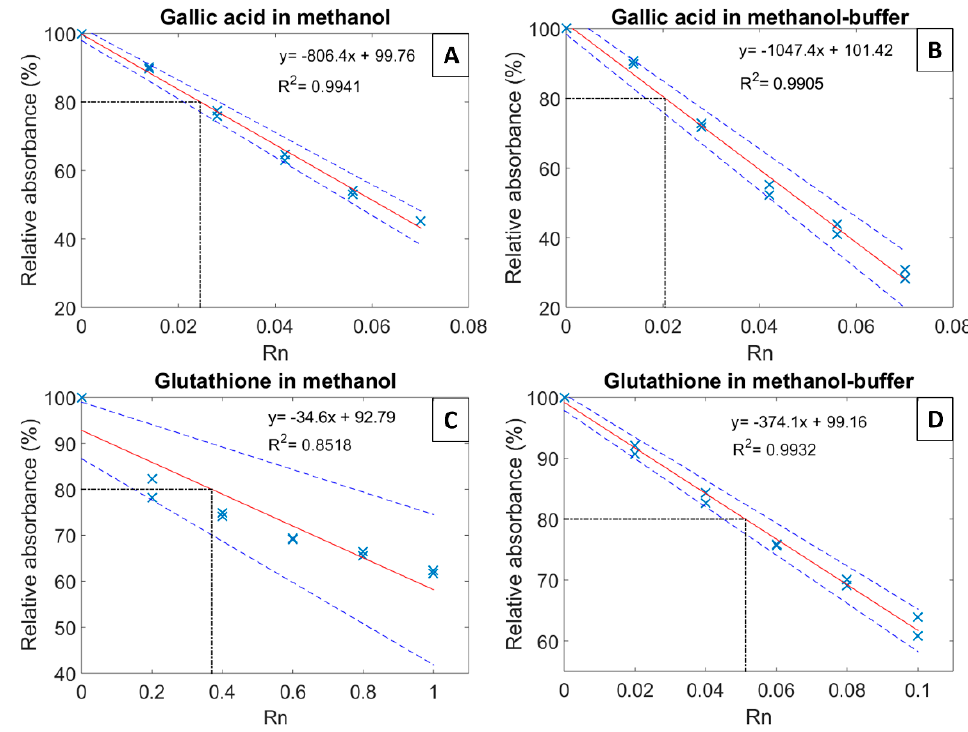
Figure 1. DPPH measurements of gallic acid ( A , B ) and glutathione ( C , D ) in methanol and in methanol-buffer (0.1 M of citric acid and 0.2 M of phosphate disodium, pH 3.6, final proportion 60% methanol and 40% buffer). The plain line (red) represents the regression line, and the two dashed lines (blue) the 95% confidence interval. The dot-dashed line guides the eye to EC 20 , which is the Rn value corresponding to a 20% decrease of the initial absorbance. Rn represents the ratio between the molar number of standard compound (in mol) added to the initial molar number of DPPH (in mol).